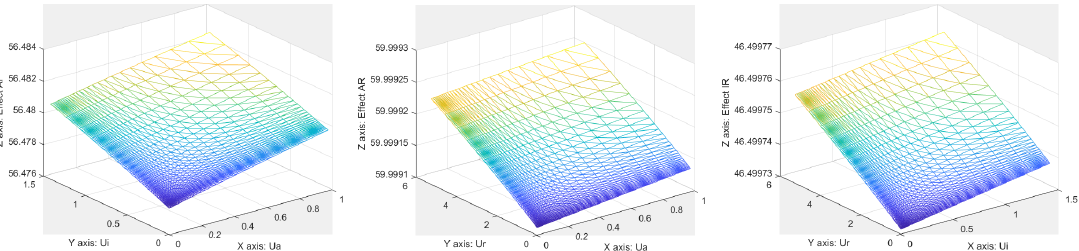
Figure A3. Surface responses obtained for σ = 4 for each drug